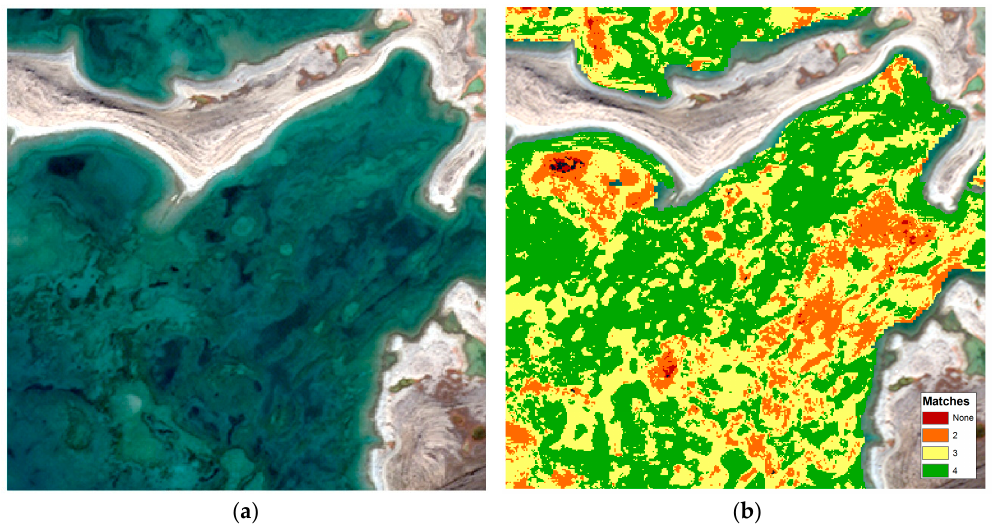
Figure 7. Illustration of potential use of the level of confidence technique for quality control (QC). ( a ) Section of WorldView-2 imagery and ( b ) the associated number of matching SDB approaches. Note